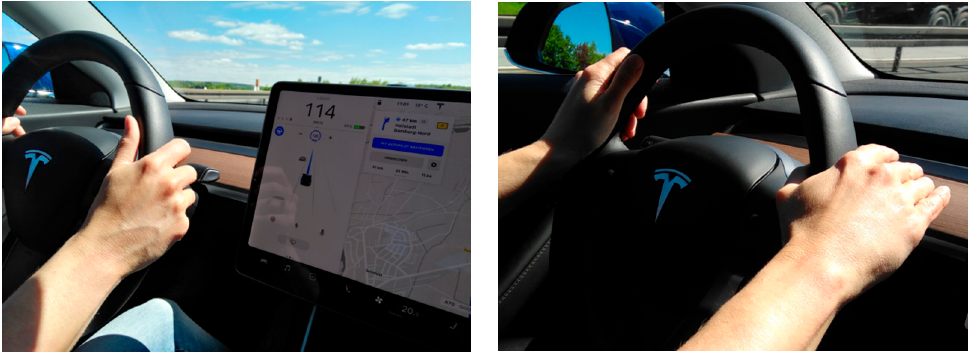
Figure 5. HMI elements of Tesla Autopilot.